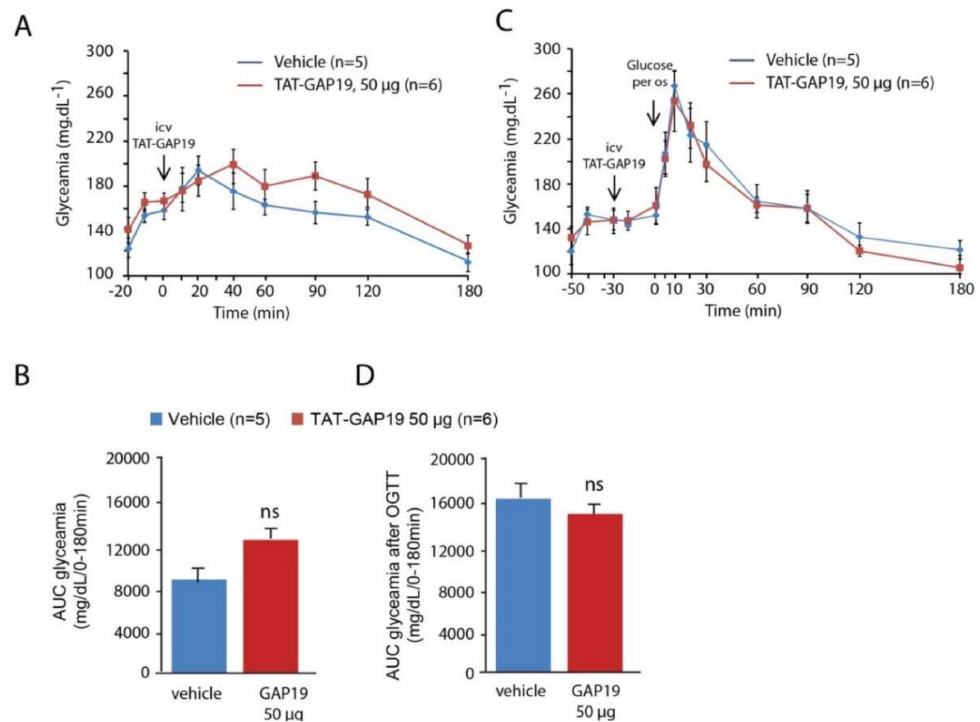
Figure 7. ( A ) : Glycaemia measured in fasted mice having received either i.c.v. injection of sodium chloride (NaCl) 0.9% or TAT-GAP19 50 µ g. Arrow indicates the time of TAT-GAP19 icv administration. ( B ): Quantification of area under the curves (AUC) measured between 0 and 180 min after i.c.v injection of either NaCl 0.9% or TAT-GAP19 (50 µ g). Arrows indicate the times of TAT-GAP19 and glucose administrations. ( C ) : Time-course changes in blood glucose level after per os glucose administration (1.5 g / kg) performed 30 min after i.c.v. injection of either NaCl 0.9% or TAT-GAP19 (50 µ g) in fasted mice. ( D ): Quantification of AUC measured at between 0 and 180 min after per os glucose administration